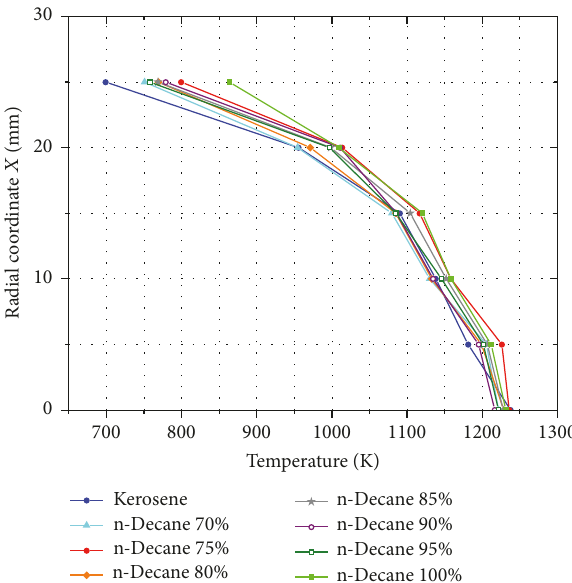
Figure 11: Comparison of the temperature for the surrogate and the kerosene burning.